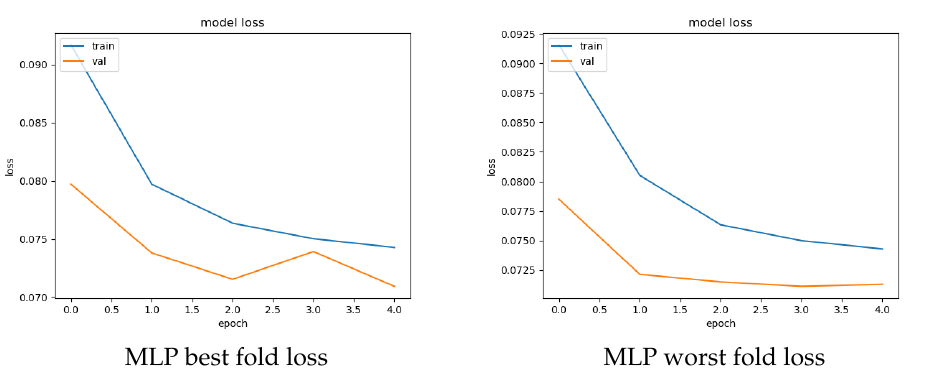
Figure 3. Best performer (MLP) loss per epoch performance for the non-802.11 feature set.